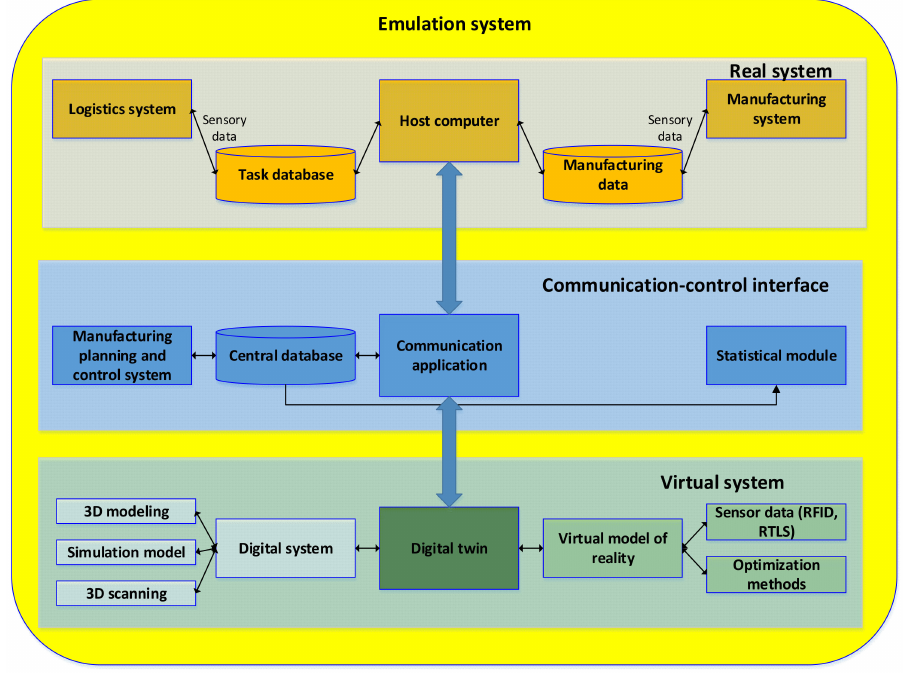
Figure 1. Design of system structure for verification of logistics processes using